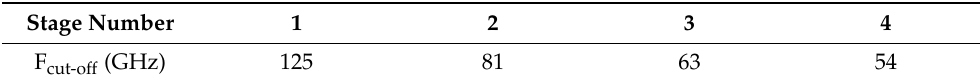
Figure 6. Comparison of ( a ) S11 and ( b ) S21 according to transistor (TR) size with current consumption. Table 1. Simulated 3-dB cutoff frequency (F cut-off ) according to the stage number when the transistor size is fixed to 30 μ m.